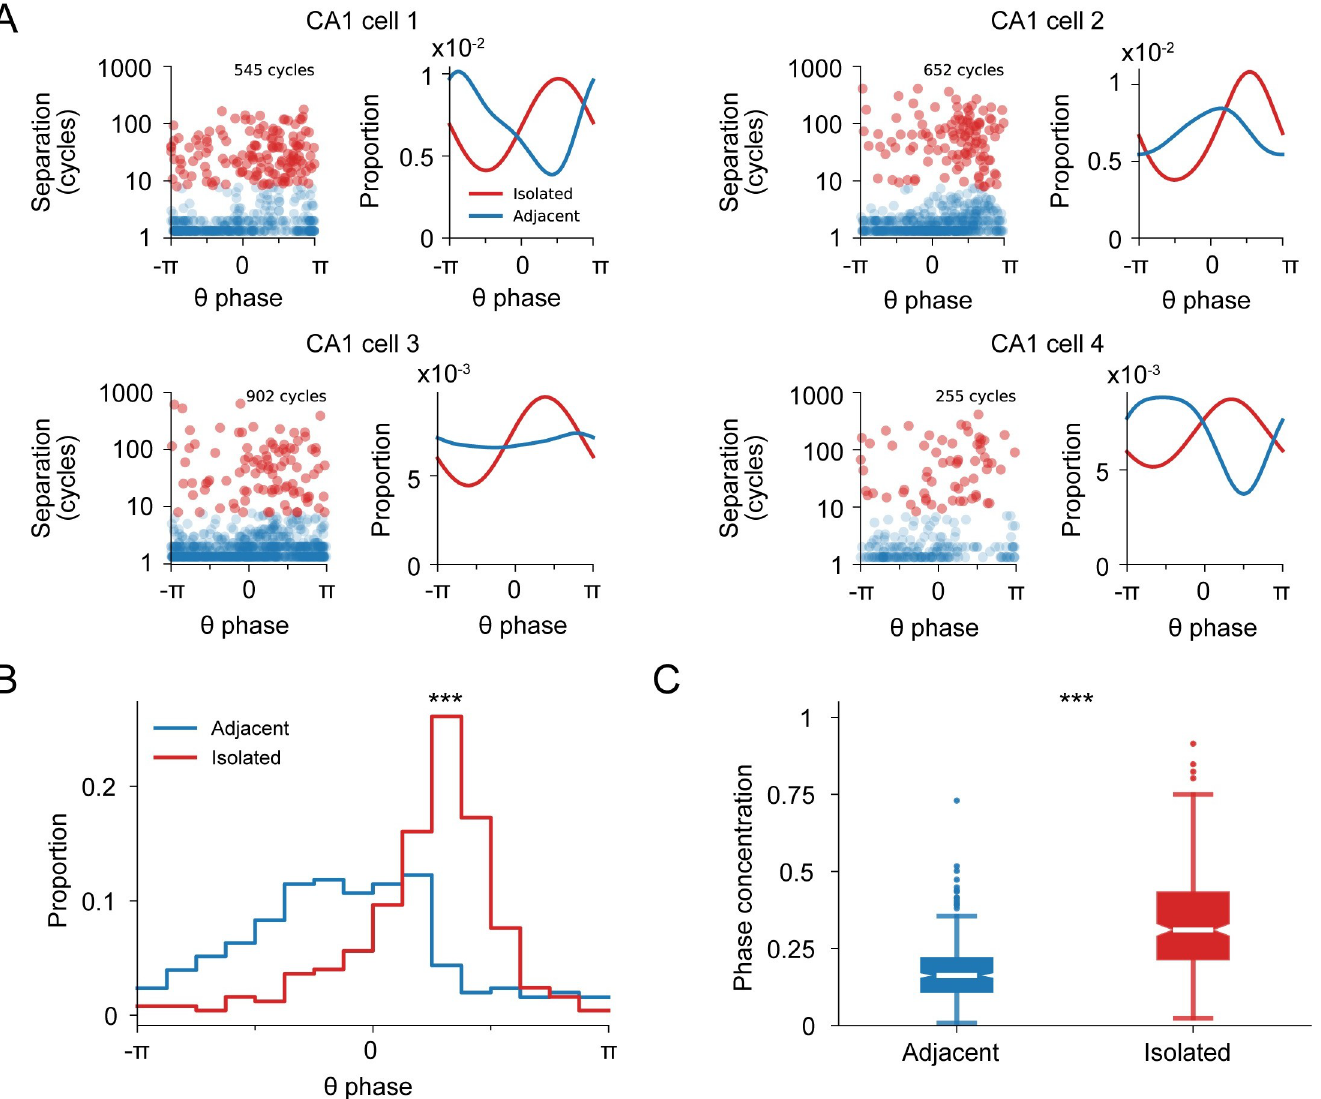
Fig 3. Isolated and adjacent spiking activity show distinct phase locking to hippocampal theta oscillations. (A) Theta cycle separation versus mean spike theta phase preference. A separation threshold of 8 cycles between isolated and adjacent classification is based on Fig 1. Histogram shows the mean spiking phase for each theta cycle. Examples correspond to the 4 cells from Fig 1. Circular median test between the isolated and adjacent distributions: top left: p = 1.4 × 10 − 5 ; top right: p = 8.9 × 10 − 8 ; bottom: left p = 2.4 × 10 − 4 ; bottom right: p = 5.3 × 10 − 2 . (B) Mean theta phase preference distribution for adjacent and isolated spiking for the CA1 cell population ( n = 247 cells). Circular median test: p = 0. (C) Mean theta phase concentration distribution for adjacent and isolated spiking for the CA1 cell population ( n = 247 cells). Wilcoxon rank sum test: p = 2.09 × 10 − 28